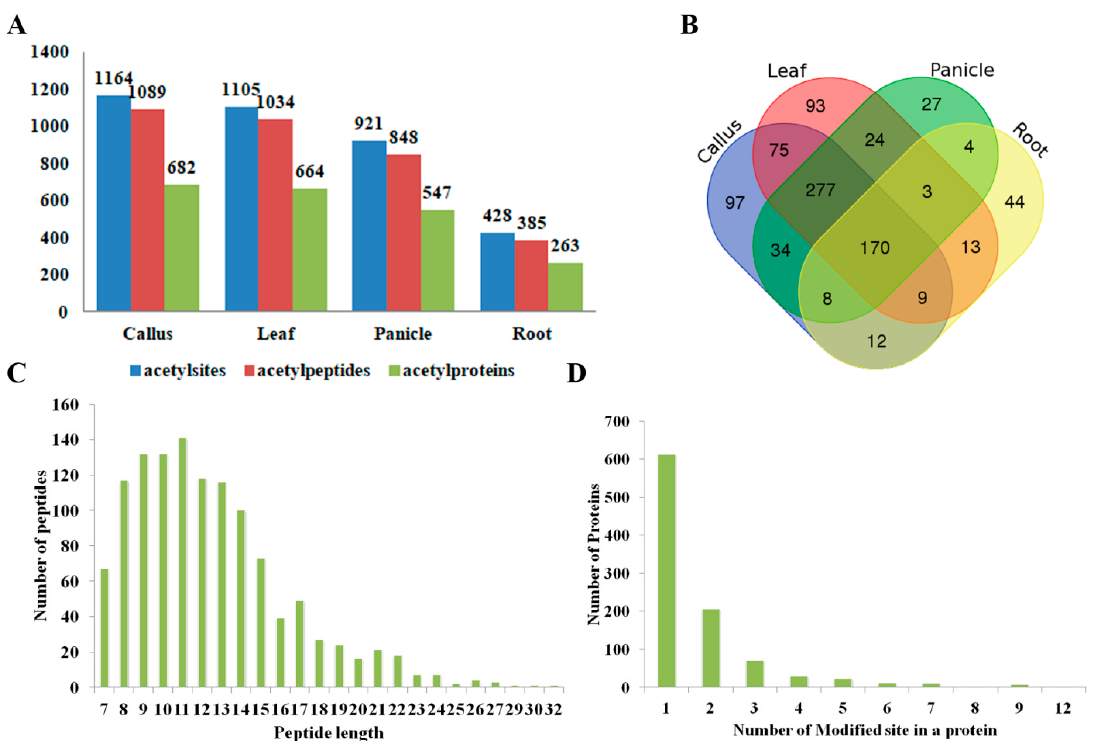
Figure 2. ( A ) The counts of acetylsites, acetylpeptides and acetylproteins in the callus, leaf, panicle, and root, respectively; ( B ) Venn diagram showing the overlap of our identified acetylproteins in the callus, leaf, panicle, and root, respectively; ( C ) Numbers of each identified peptide length; ( D ) Numbers of each identified modified site in a protein.